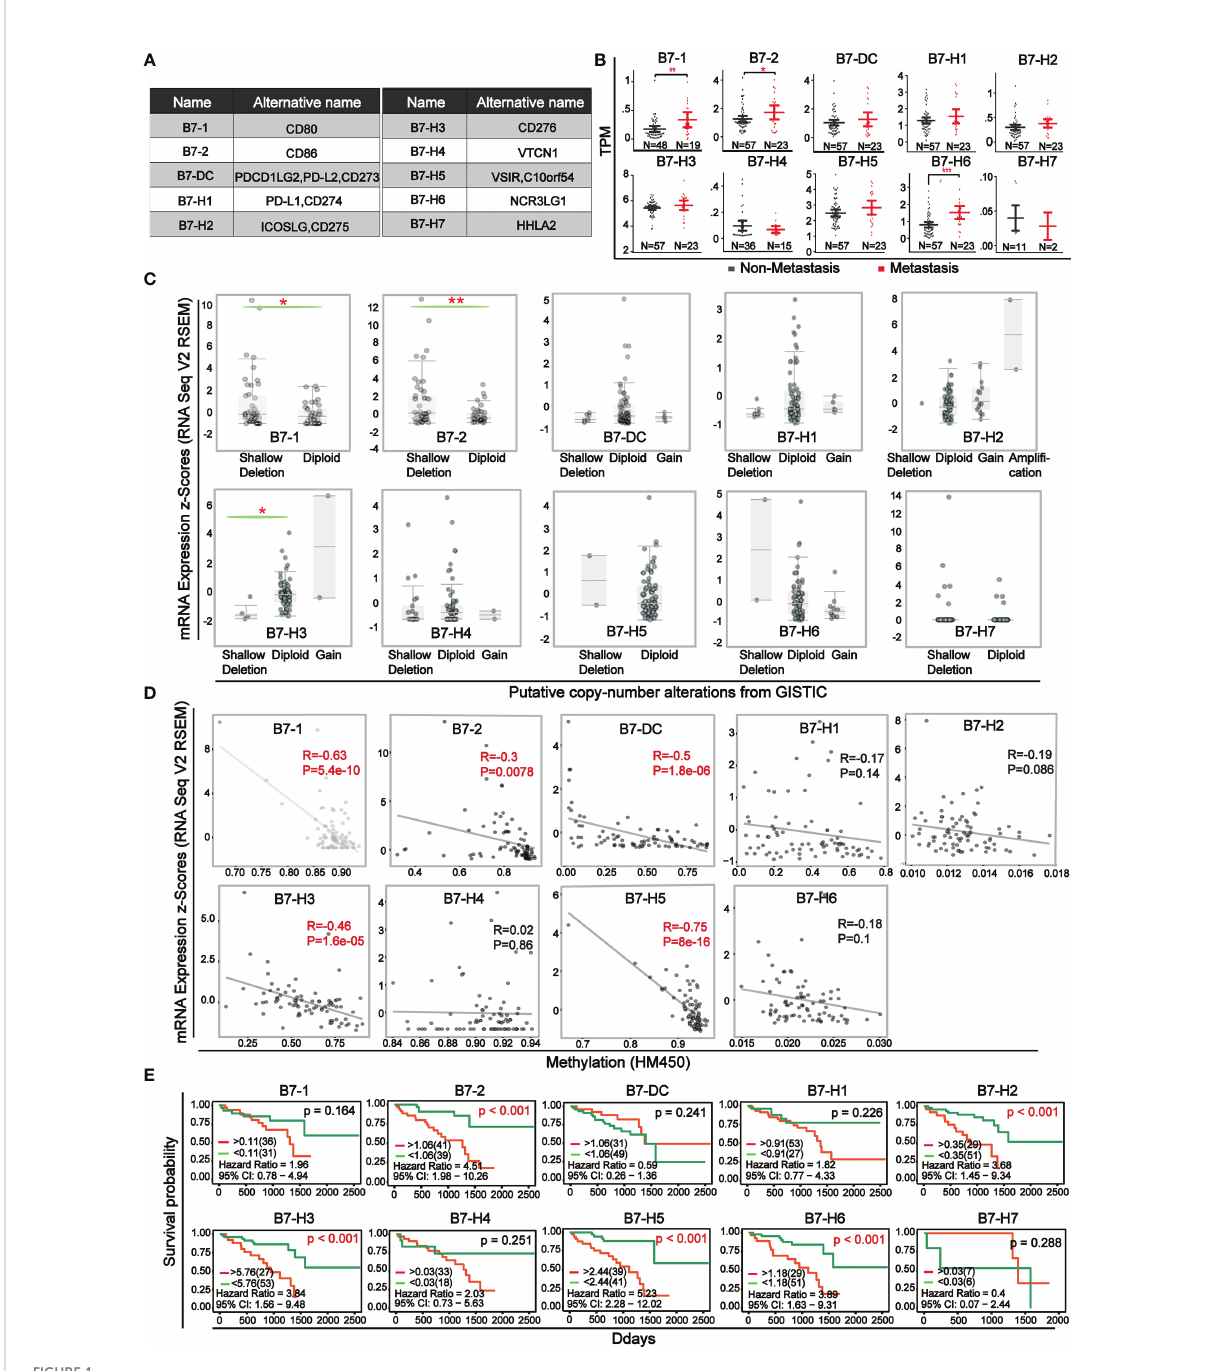
FIGURE 1 Expression level and survival curve of B7 family in UVM (A) Multiple denominate names of each B7 family member. (B) The comparison of mRNA expression of B7 family members between non-metastatic and metastatic UVM. Expression data and clinical information were from the TCGA database. N represented the sample size. (C) Association of B7 family member mRNA expression with gene alteration. (D) Correlation of B7 family member mRNA expression with promotor methylation. (E) Kaplan-Meier survival curves of B7 family genes in UVM based on the expression level. (* P < 0.05**, P < 0.01, and *** P <